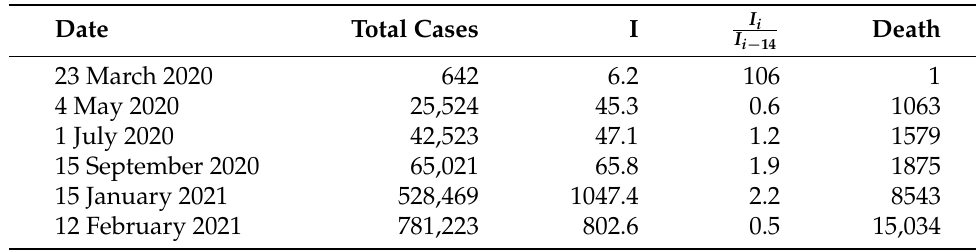
Table 4. Data for Portugal: Total cases, Cases per 100,000 inhabitants in the last 14 days, rate of Cases in the last 14 days and the previous 14 days interval, Death related to COVID-19.